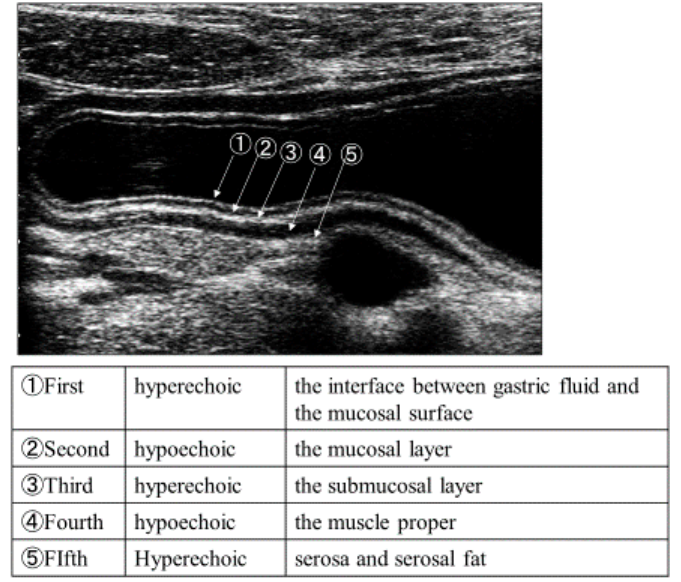
Figure 2. Five-layer stratification of stomach by sonography. The first inner hyperechoic layer represents the interface between gastric fluid and the mucosal surface; the second hypoechoic layer shows the mucosal layer; the third hyperechoic layer shows the submucosal layer; the fourth hypoechoic layer shows the muscle proper; and the fifth hyperechoic layer shows serosa and serosal fat.